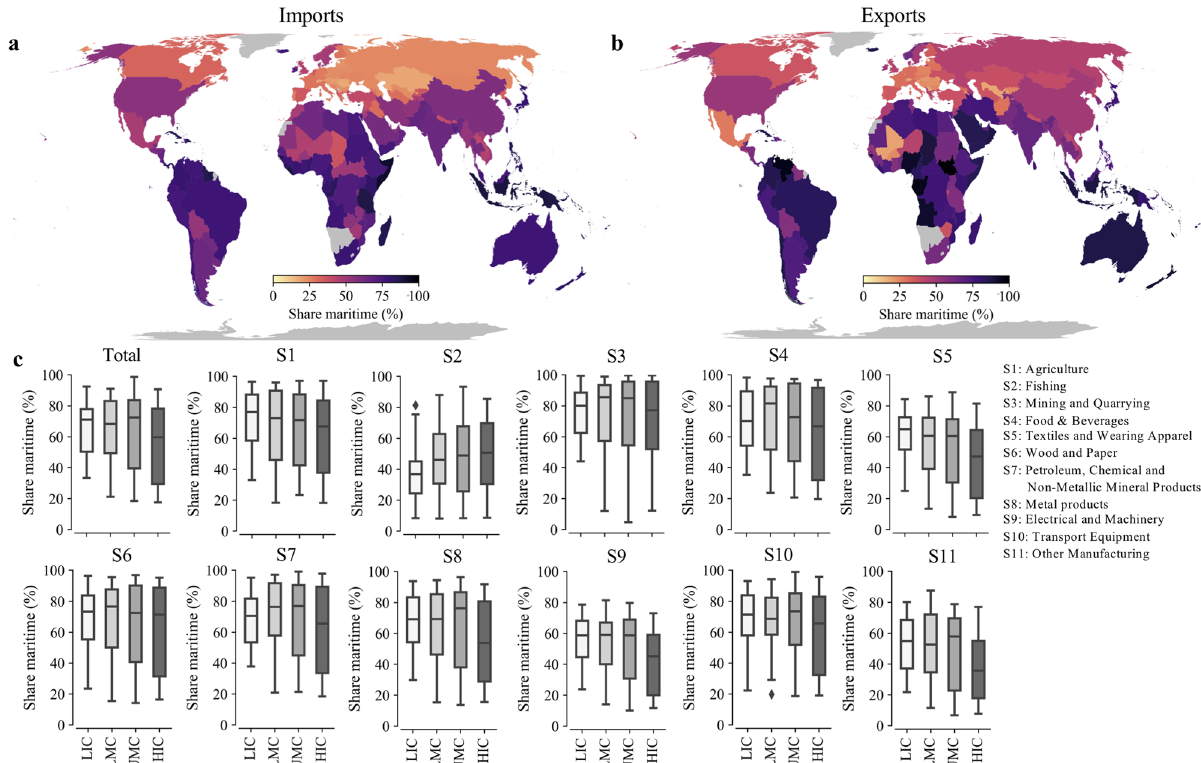
Fig.1|Theshareofmaritimetransportinglobaltrade. Country ’ spercentageof maritime imports ( a ) and exports ( b ) based on the 2015 trade network. c Boxplots of the percentage maritime imports per economic sector with countries grouped